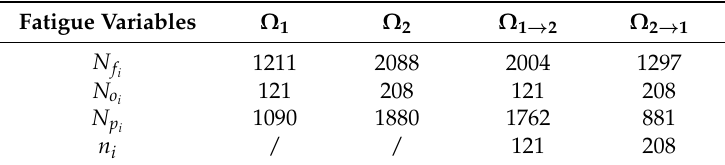
Table 4. Fatigue life information.